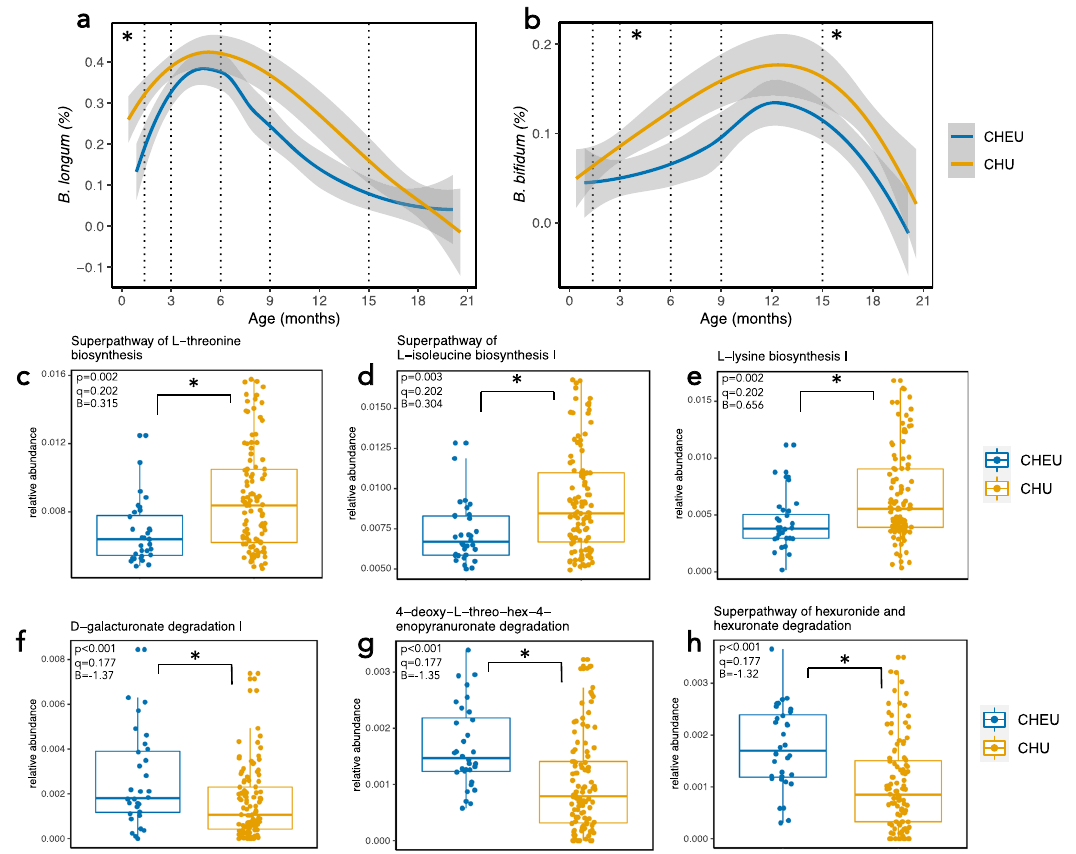
Fig. 4 | Maternal HIV infection is associated with reduced abundance of Bi fi - dobacteria abundance and amino acid biosynthesis genes. Relative abundance(0 – 1) of Bi fi dobacterium longum ( a ) and B. bi fi dum ( b ) in the gut microbiome of CHEU and CHU at each age category via multivariate regression analyses (* q <0.1; n =859 samples total. Lines represent smoothed conditional means and grey shaded areas represent 95% con fi dence intervals). Multivariate regression of gene pathways demonstrates reduced abundance of amino acid